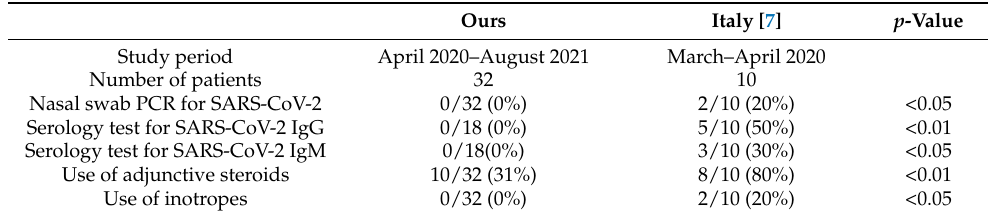
Table 1. Summary of the results of the tests for severe acute respiratory syndrome coronavirus type 2 and treatments in our hospital and in Italy.